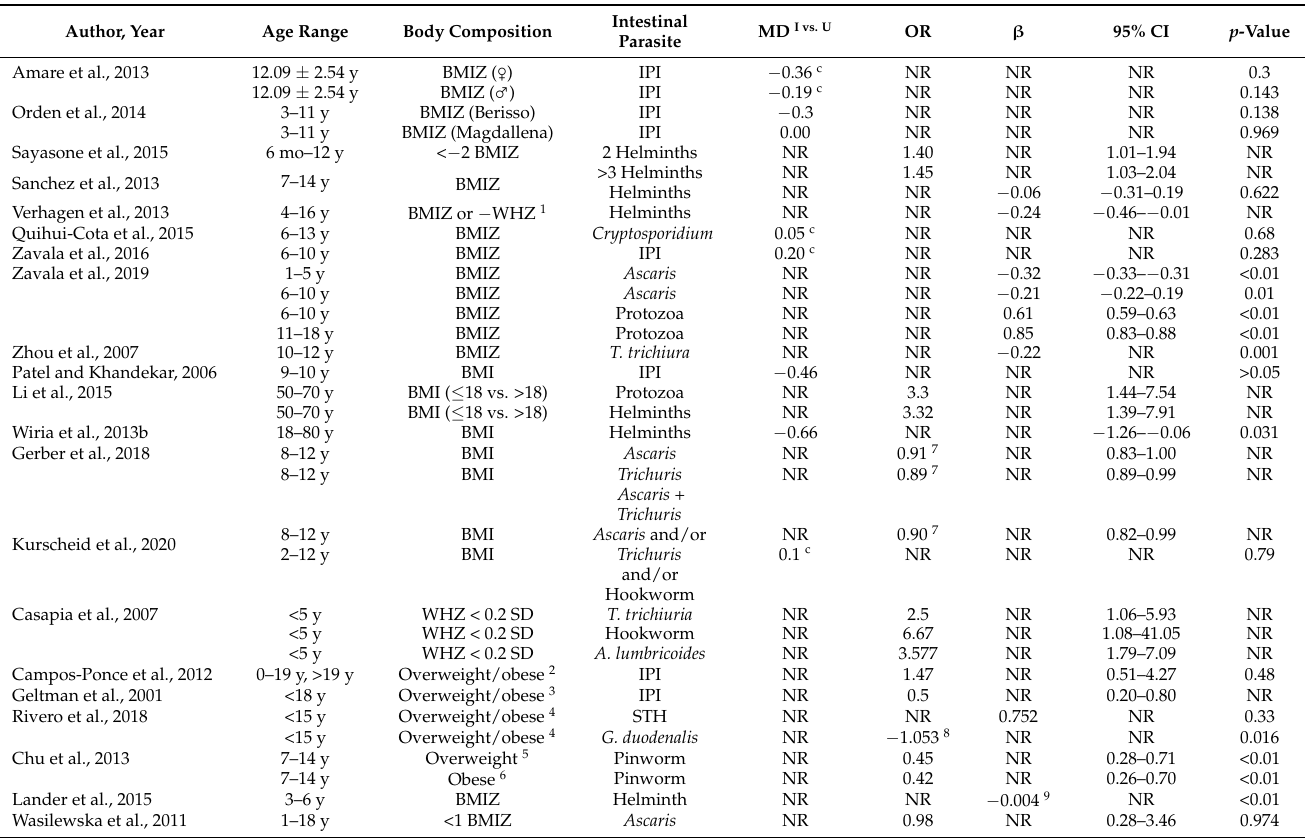
Table 5. Associations between intestinal parasite infection status and proxy (weight-for-height) measures of body